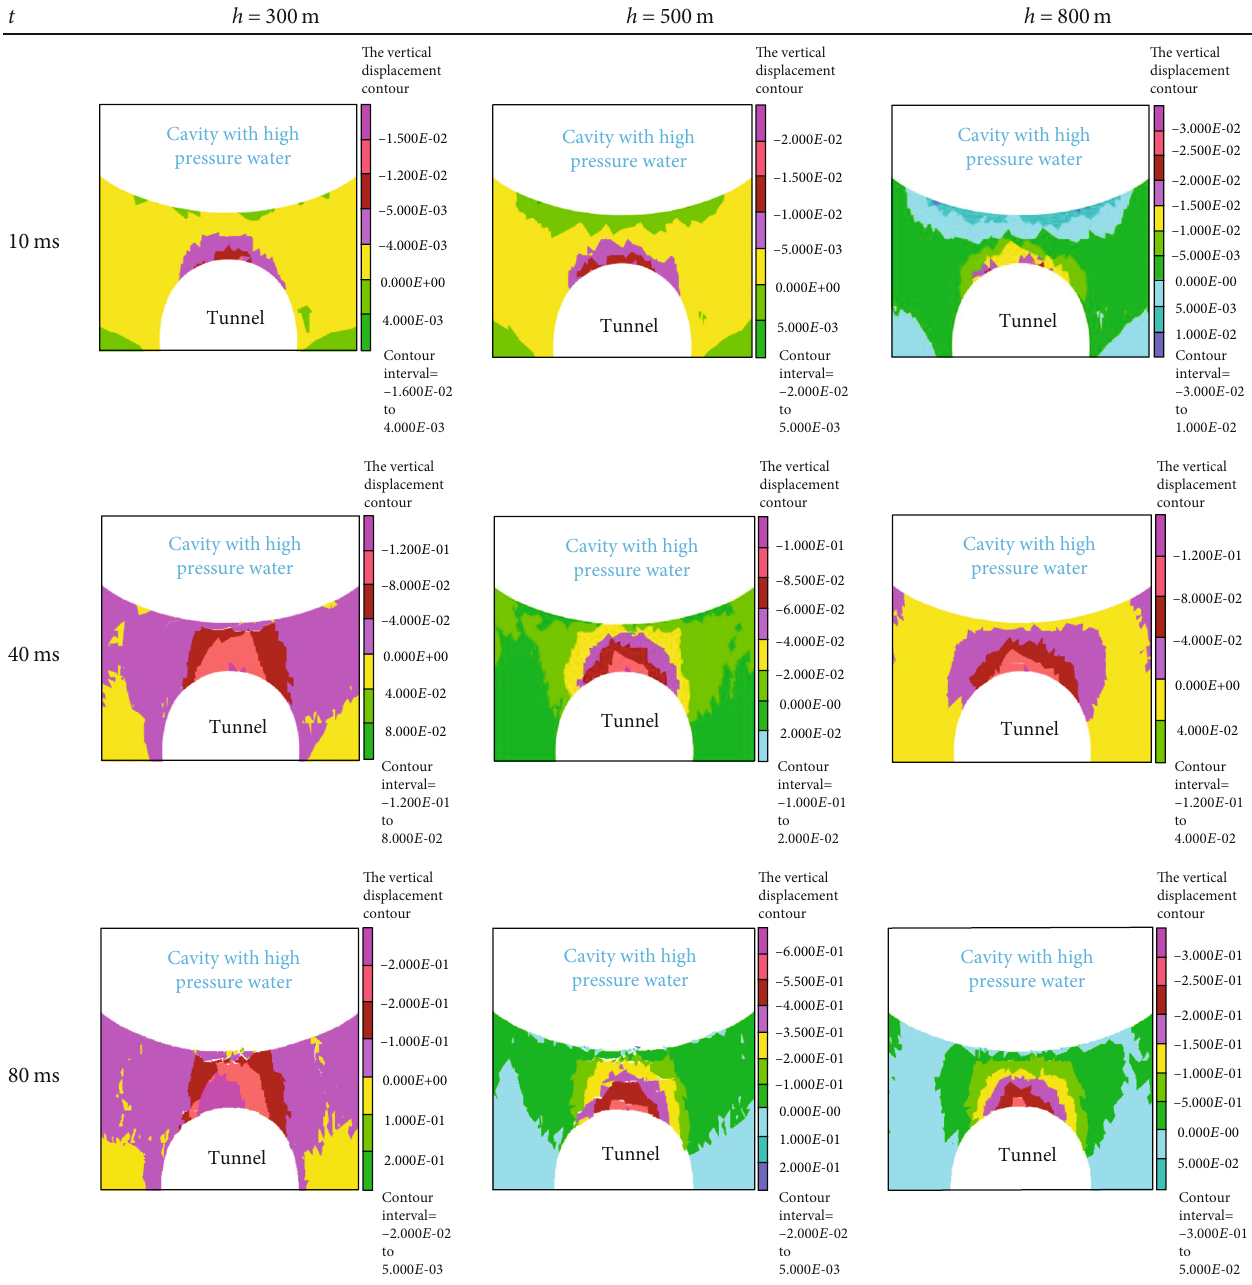
Table 7: The vertical displacement contour under the three cases of H = 300 , 500, and 800m at t = 10 , 40, and 80 ms. t h = 300